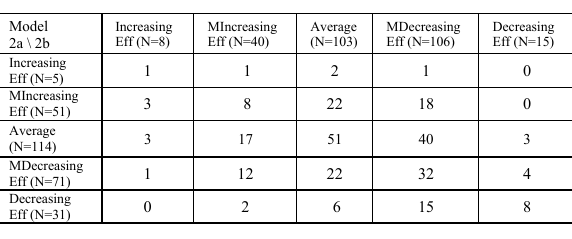
Table 3. Count matrix of latent class membership results between Model 2a and Model 2b